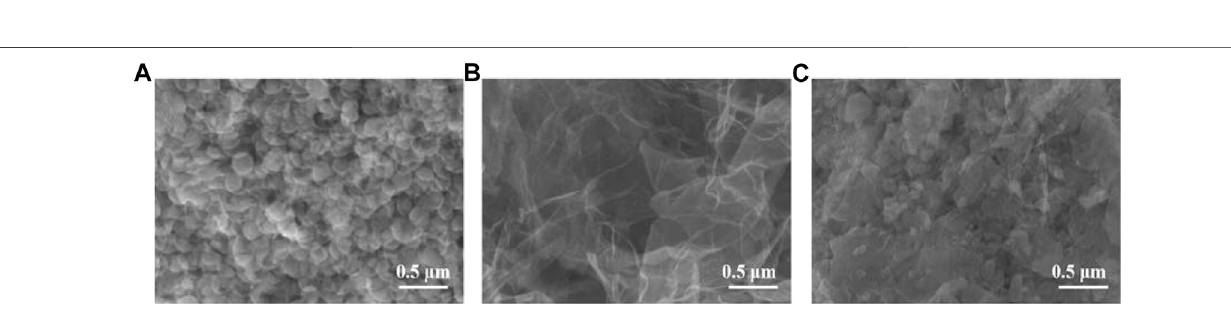
Frontiers in Chemistry |